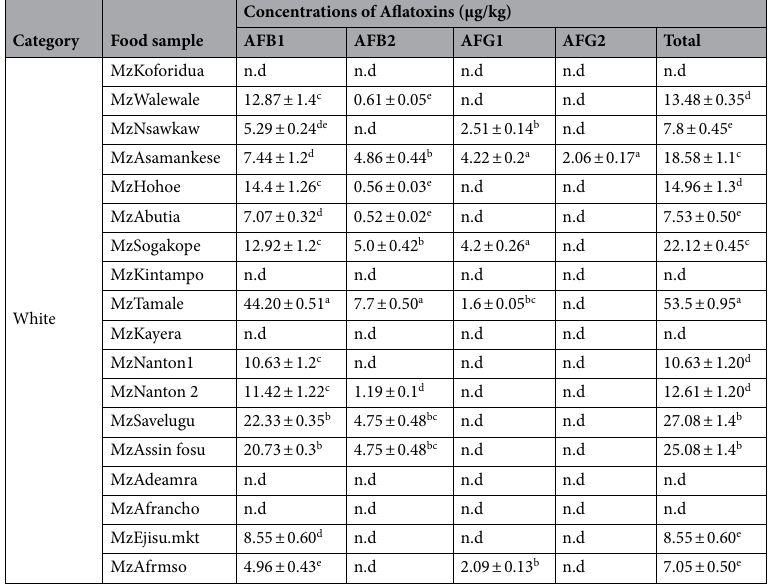
Table 4. Concentration of aflatoxin types in different maize samples from different locations of Ghana. Mean ± Standard Deviation that do not share a letter are significantly different (p > 0.05). n.d not detected.